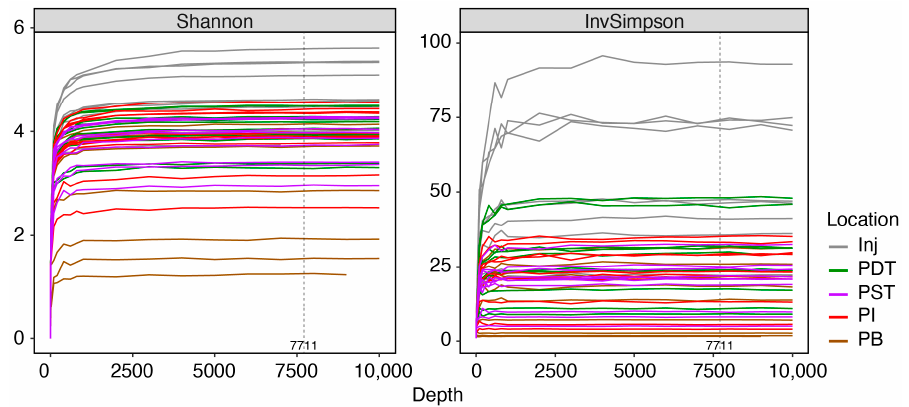
Figure A1. Rarefaction curves for the microbial sample set based on Shannon and Inverse Simpson diversity indices. Shannon and Inverse Simpson indices stabilized well before the minimum sequencing depth across all samples (7711 ASVs) was reached.